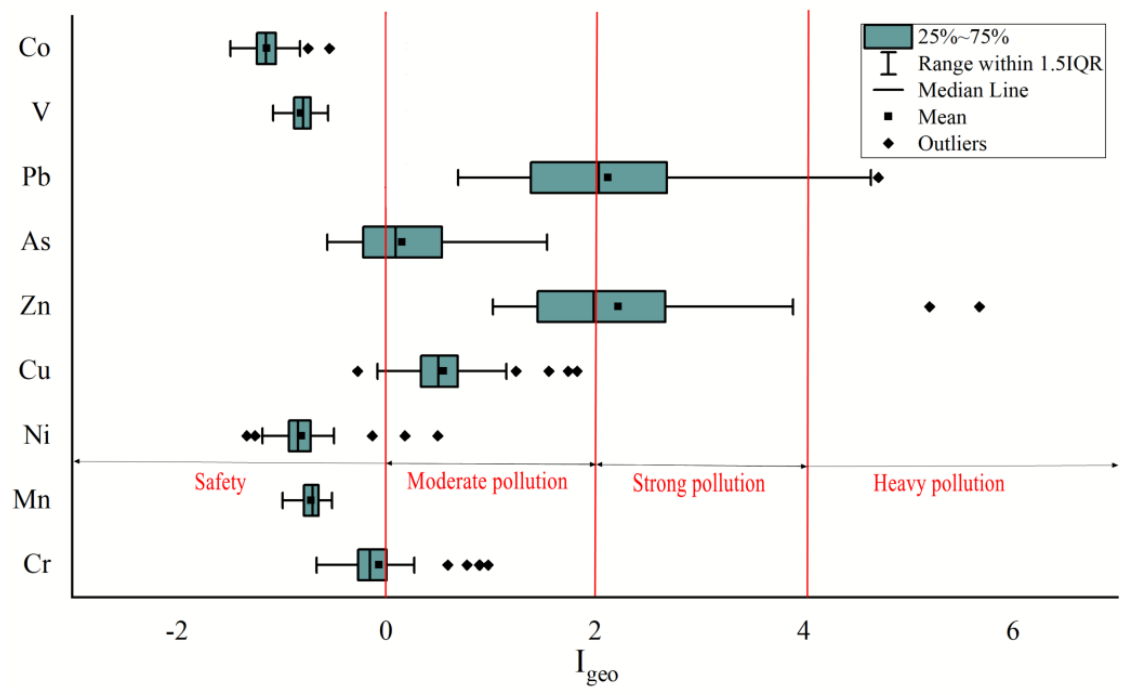
Figure 2. Distribution of the geoaccumulation indexes of heavy metals.